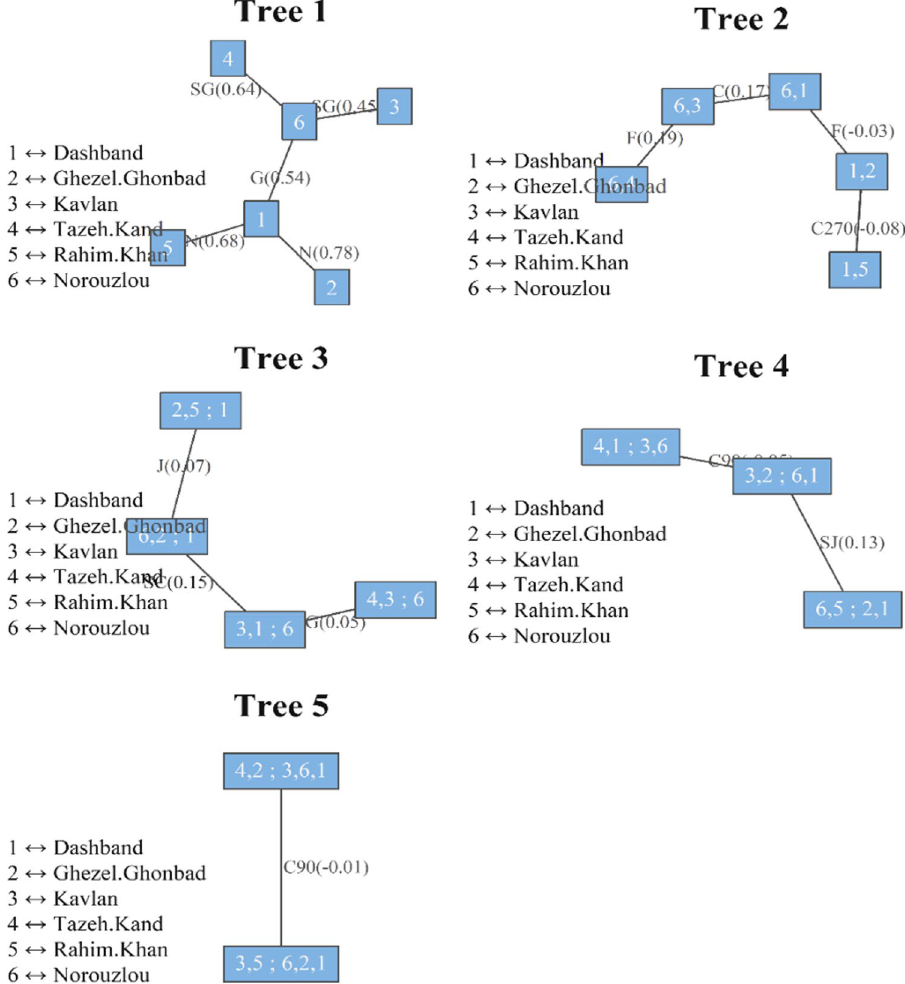
Fig. 4 The tree structure of